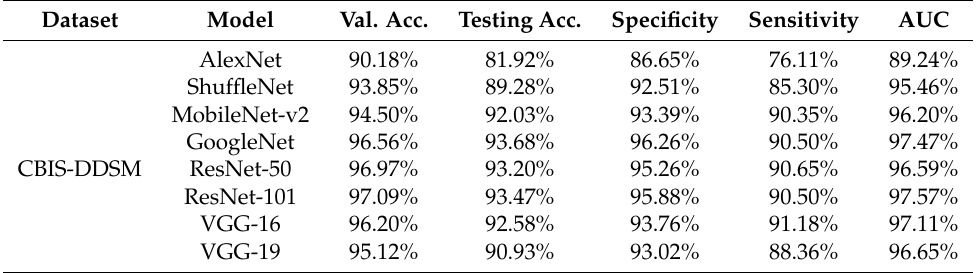
Table 8. The comparison of various pre-trained models with SSTL and DSTL on MIAS and BCDR datasets.